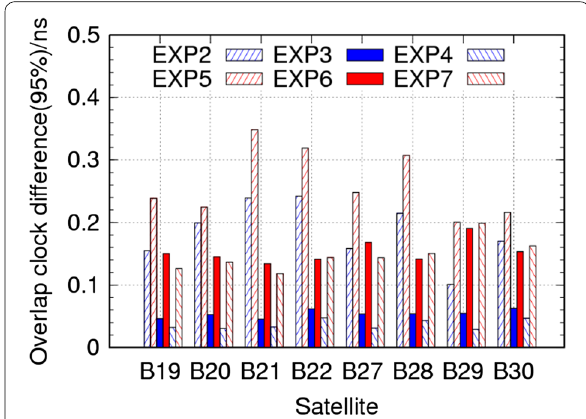
Fig. 8 Comparison of clock accuracies obtained by different experiments